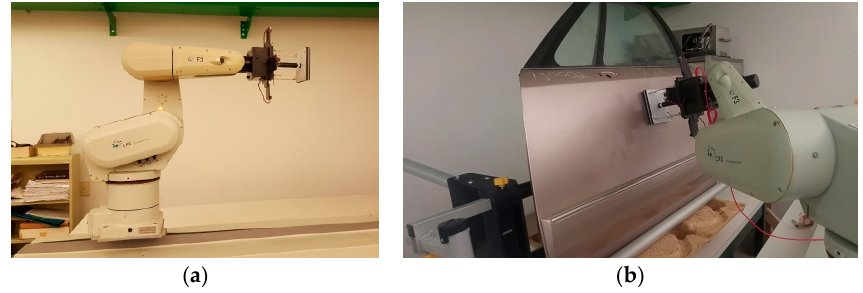
Figure 20. Experimental performance evaluation of the compliant wrist: ( a ) mounted as the end-effector of a CRS-F3 manipulator and embedded instrumentation integrated in the robot control loop; and ( b ) performing surface following over various surfaces. Sensors 2017 , 17 , 1384